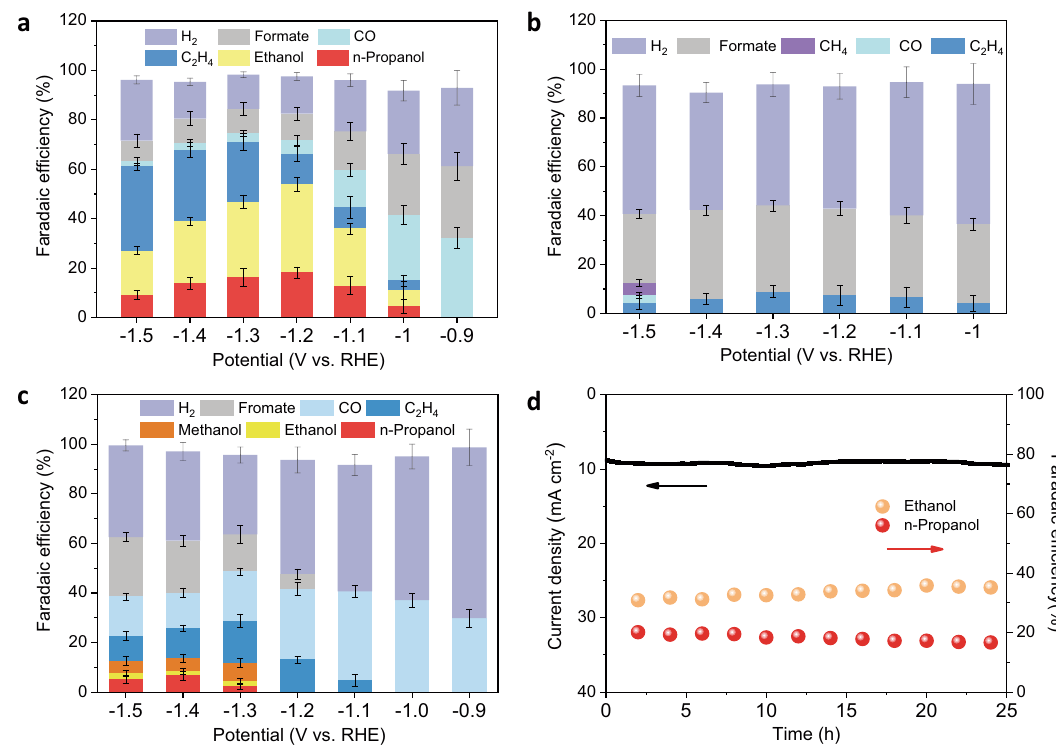
Fig. 2 | Electrocatalytic CO 2 RR performances. a – c FEs of various reduction pro- ducts at different potential for Hex-2Cu-O ( a ), Hex-2Cu-2O ( b ), and Oct-2Cu ( c ). d Chronoamperometric i – t curve at − 1.2V for Hex-2Cu-O with the evolution of